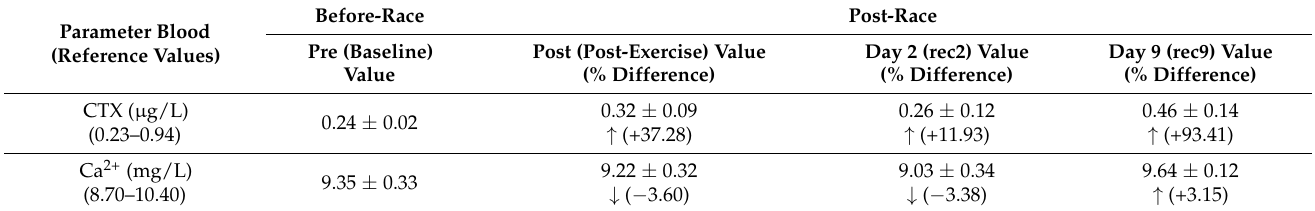
Table 3. Blood parameters before (baseline) and after race (post-exercise day 2 and post-exercise